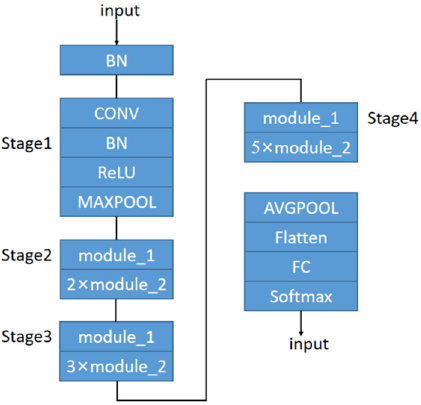
Figure 3. The structure of our ResNet model.